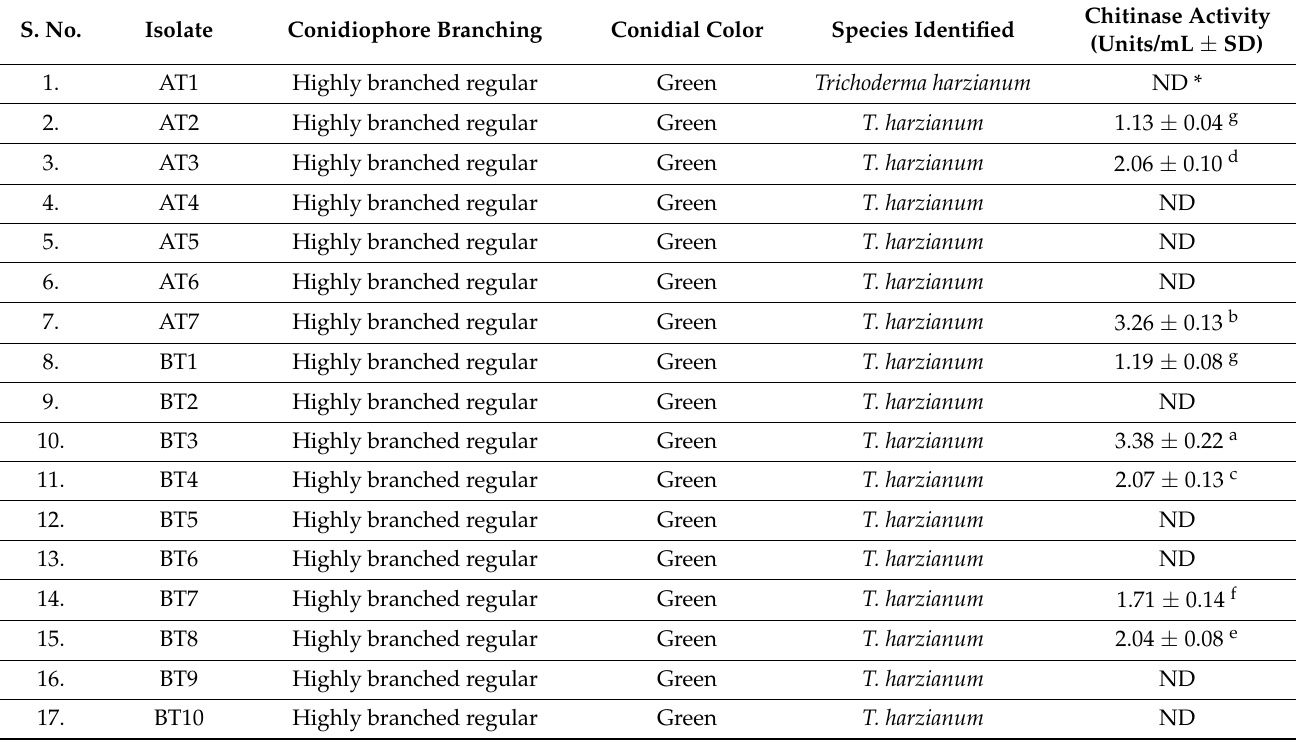
Table 1. Chitinase activity of various Trichoderma